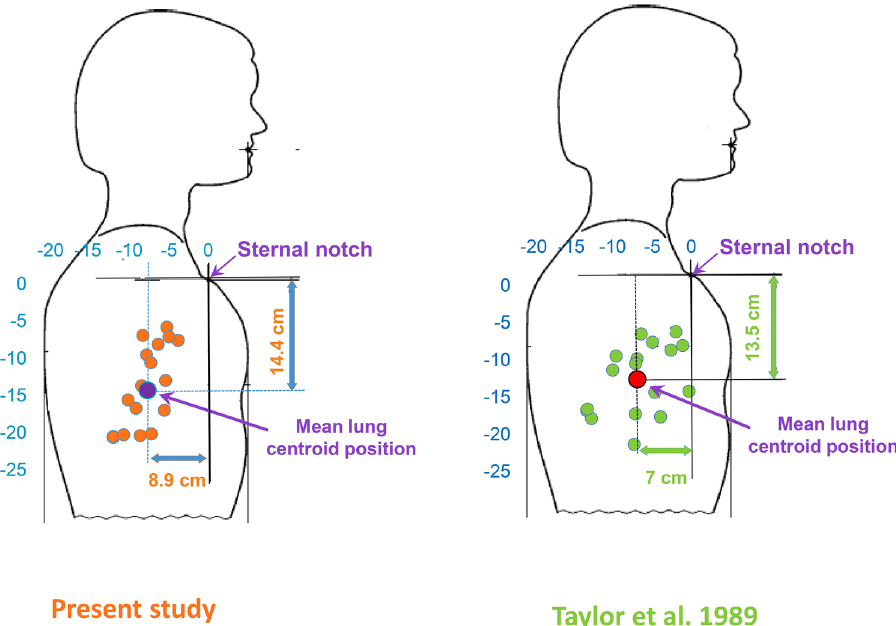
Figure 6. Individual lung centroid positions determined for head-out immersion. Both the shape of the mannequin and its dimensions (mm), as well as the scales (horizontal & vertical) correspond to those in the drawing in the European standard (EN 14143, 2013). These dimensions and shapes must be applied when designing scuba breathing devices. The position of the sternal notch, and the mean theoretical lung centroid position are shown. The left panel displays the results of the present study. Orange circles represent the lung centroid position determined for one subject. Purple circles represent the average lung centroid position based on data for all subjects combined. The right panel shows the results from Taylor and Morisson 20 . Green circles represent individual lung centroid positions for each subject. The red circle is the average lung centroid position determined by combining data from all subjects. This mean lung centroid position (135–70 mm from sternal notch) was chosen as the reference value in the European standard (EN 14143, 2013). The standard thus encompasses a broad scattering of individual values. The overall dispersion of individual values was roughly similar in the two studies, and the slightly different mean values appear